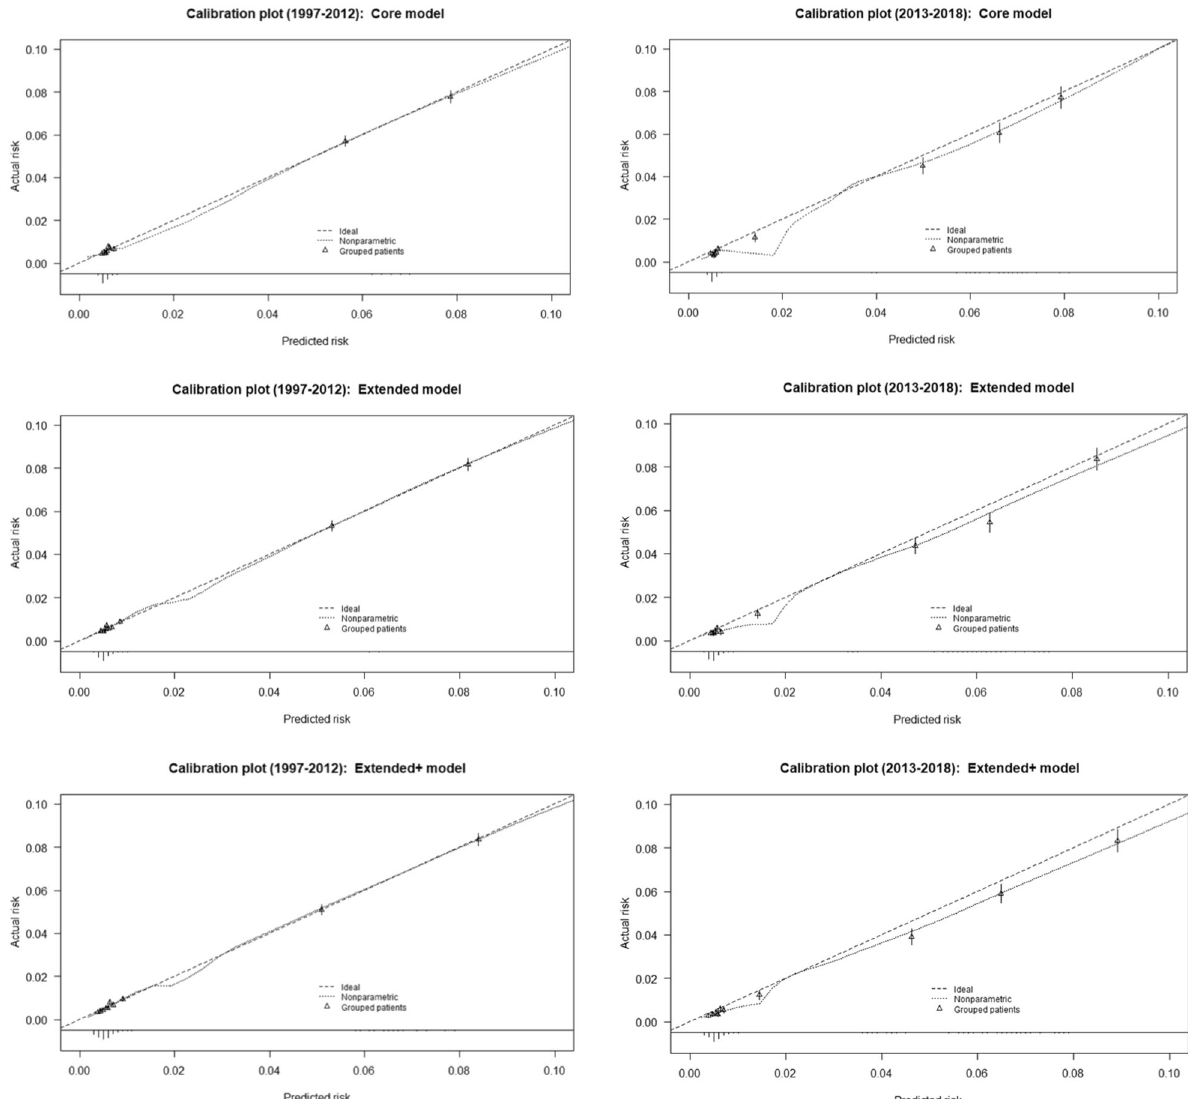
Fig. 2 Calibration plots. Core, Extended and the Extended + model for the development (years 1997 – 2012) and validation dataset (years 2013 – 2018).